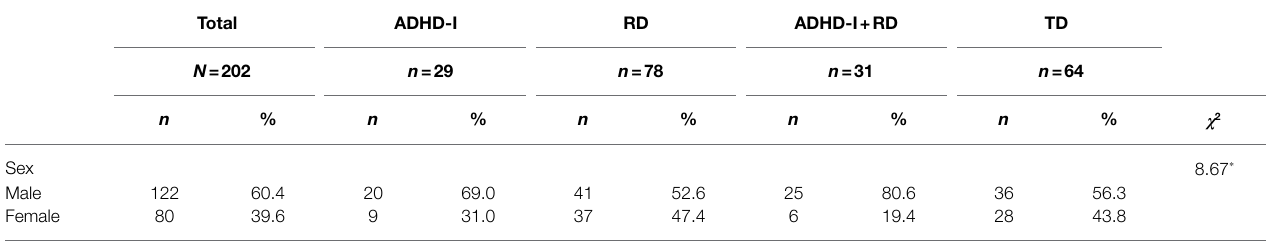
TABLE 1 | Demographic characteristics in ADHD-I, RD, ADHD-I + RD, and TD groups. TABLE 2 | Results of chi-square analysis to examine sex differences across the groups.